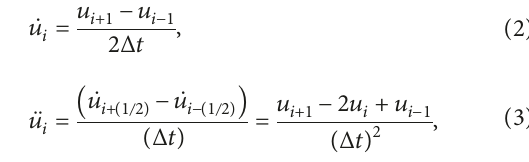
Figure 2: Demolition of guyed antenna mast in